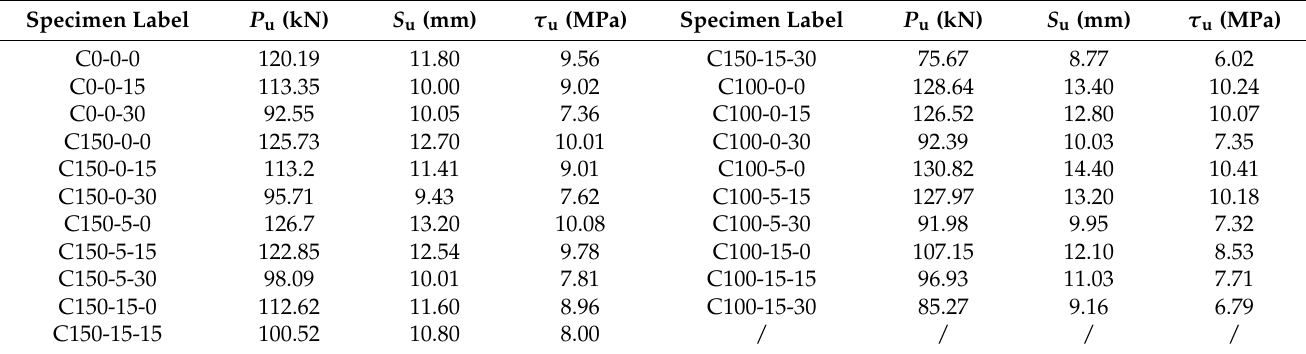
Table 3. Test data of ultimate bond strength τ u and ultimate slip S u